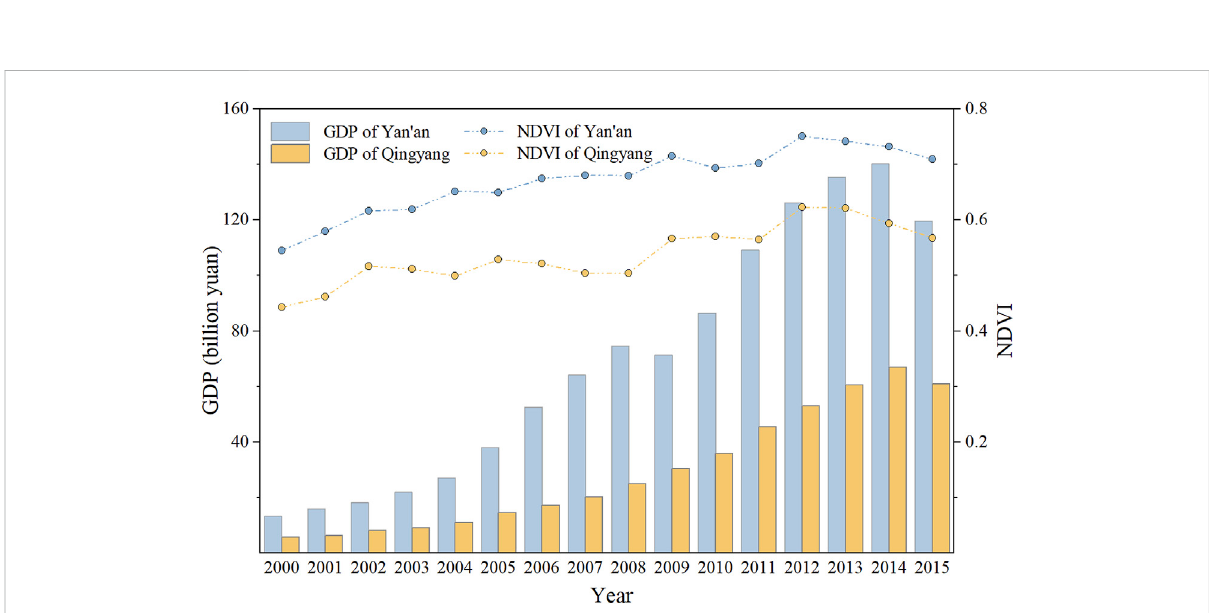
FIGURE 1 Location and digital elevation model (DEM) of the study area.